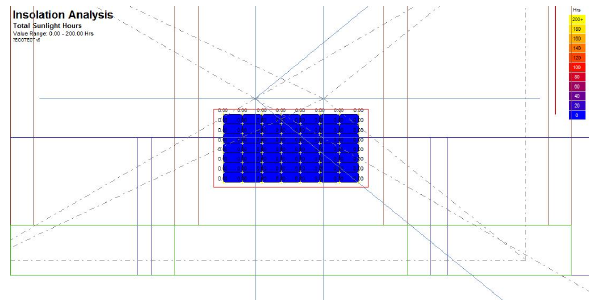
Figure 8: Annual total sunlight hours at east painting